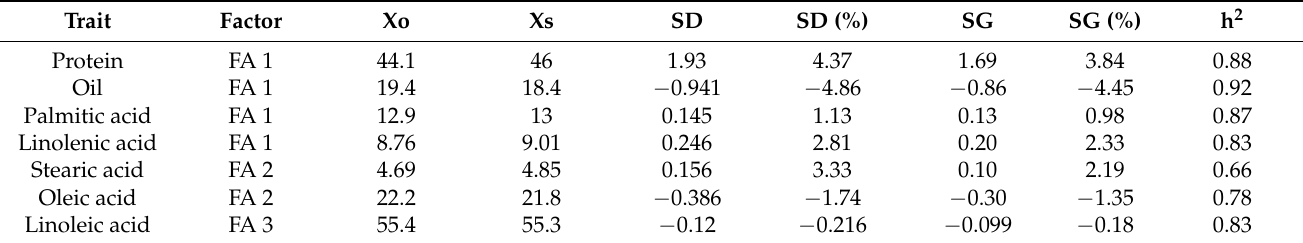
Figure 3. Genotype ranking and selected genotypes for the multi-trait stability index (MTSI) of 135 soybean genotypes based on seven seed composition traits. The selected genotypes are shown in blue color and the blue circle represents the cut-point according to the selection differential of 10%. Table 3. Estimates of selection differential, selection gain, and heritability based on MTSI for seven seed compositions evaluated for 135 soybean genotypes across five